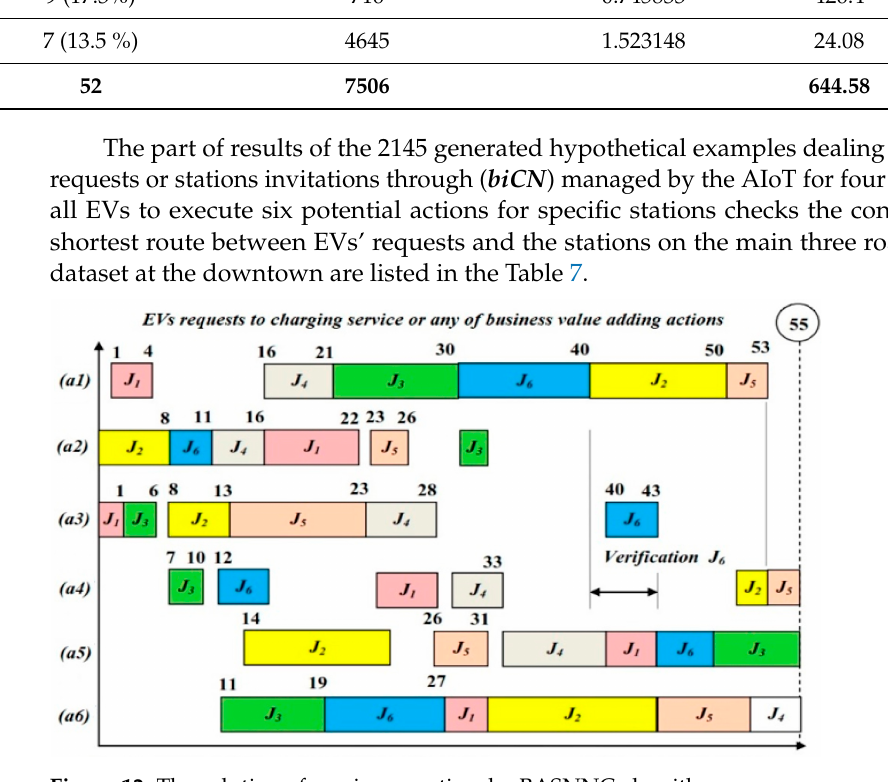
Figure 14. The lowest error in expected EVs’ service time is exponential during the period [5 Am: 11 Am]. Figure 15. The lowest error in expected EVs’ service time is Weibull during the period [5 Pm: 11 Pm].